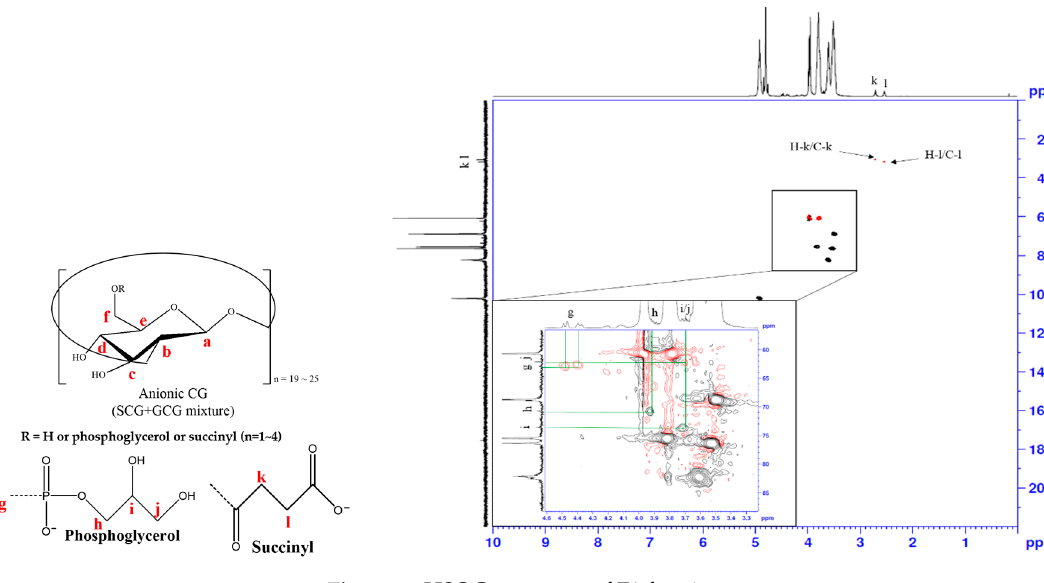
Figure 4. HSQC spectrum of F1 fraction.